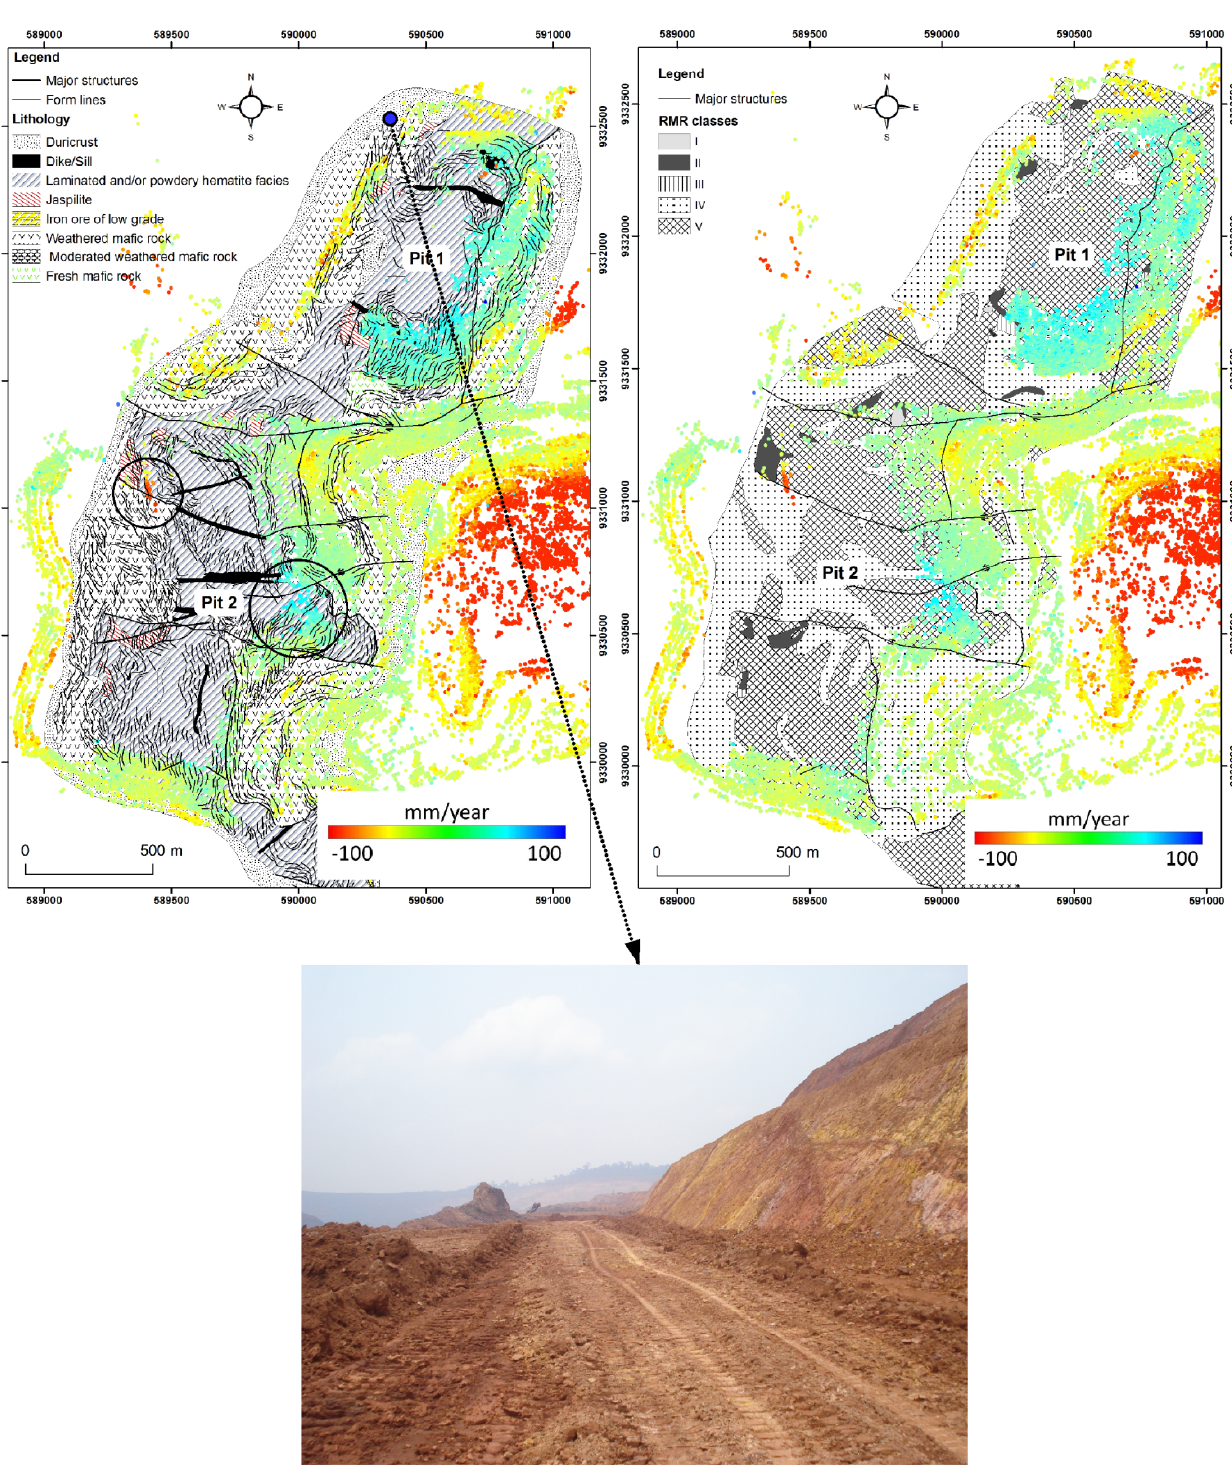
Figure 6. LOS deformation measurements (mm/year) derived from the IPTA processing of 18 SAR scenes superimposed on the generalized lithostructural ( left ) and on the geomechanical map ( right ) of the N4W iron mine. The background map was adapted from [15] and it uses an outdated topographic base map. For details about the highlighted circled areas, consult the text. The picture ( below ) depicts the re-sloping of a highly weathered rock mass composed of metavolcanic rocks (RMR V). View to southwest. Picture taken on 25 October